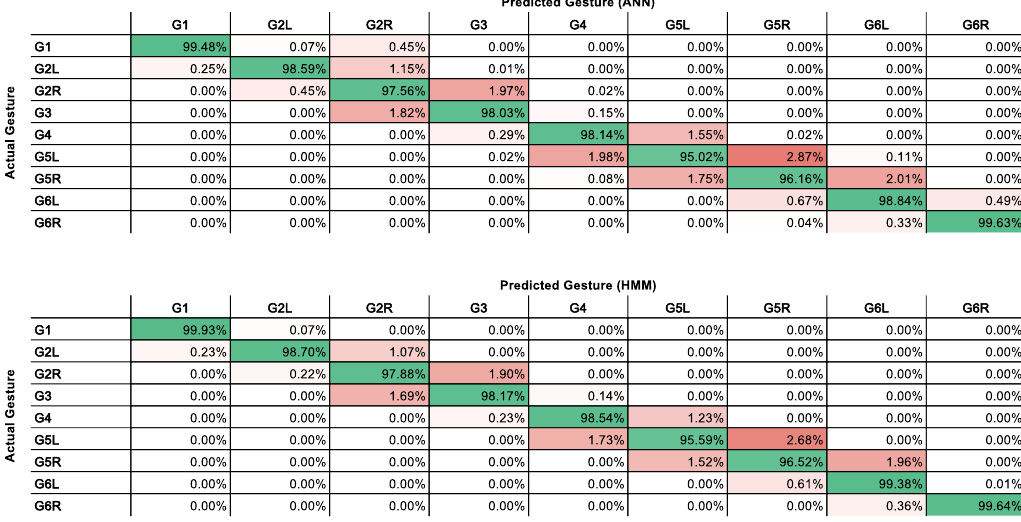
Figure 6. Confusion matrix showing recognition (green) and error (red) rates for best ANN setup before ( Top ) and after ( Bottom ) HMM